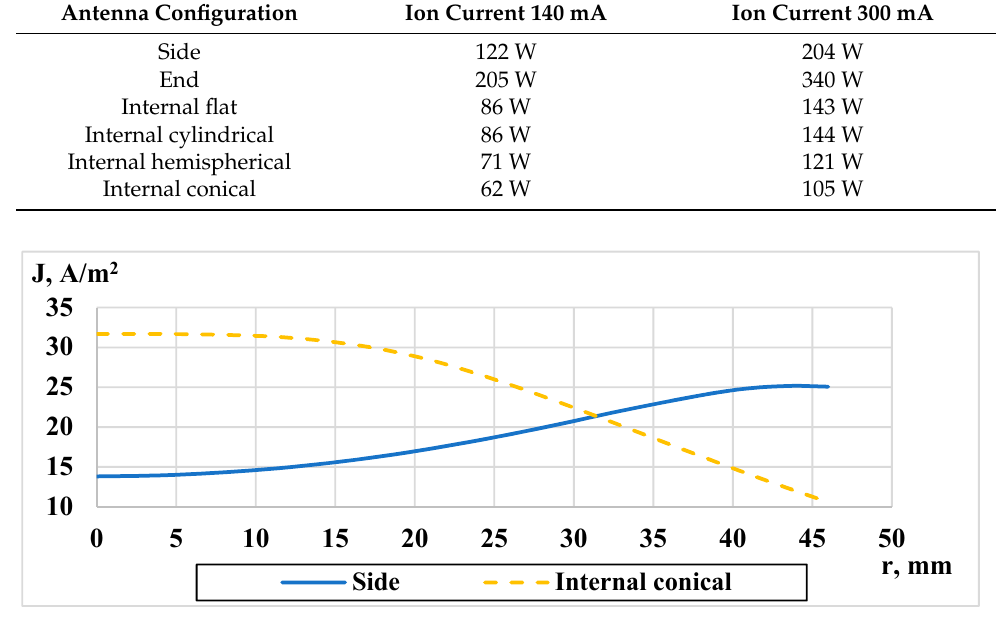
Figure 11. Radial distribution of the extracted ion current density at the xenon flow rate of 0.5 mg/s.